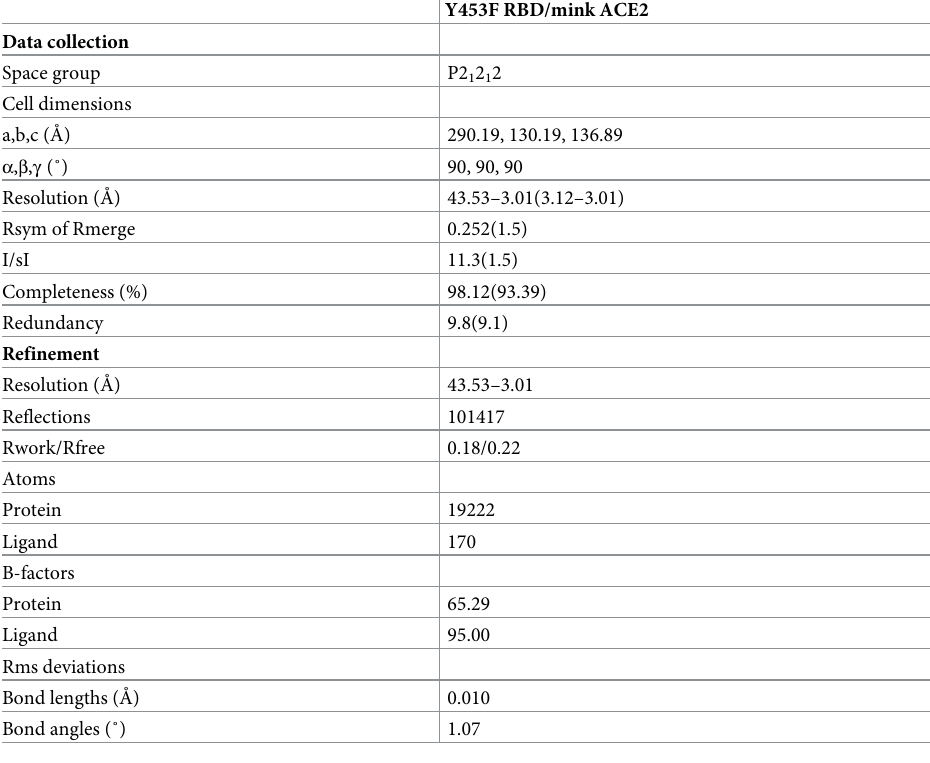
Table 1. Data collection and refinement